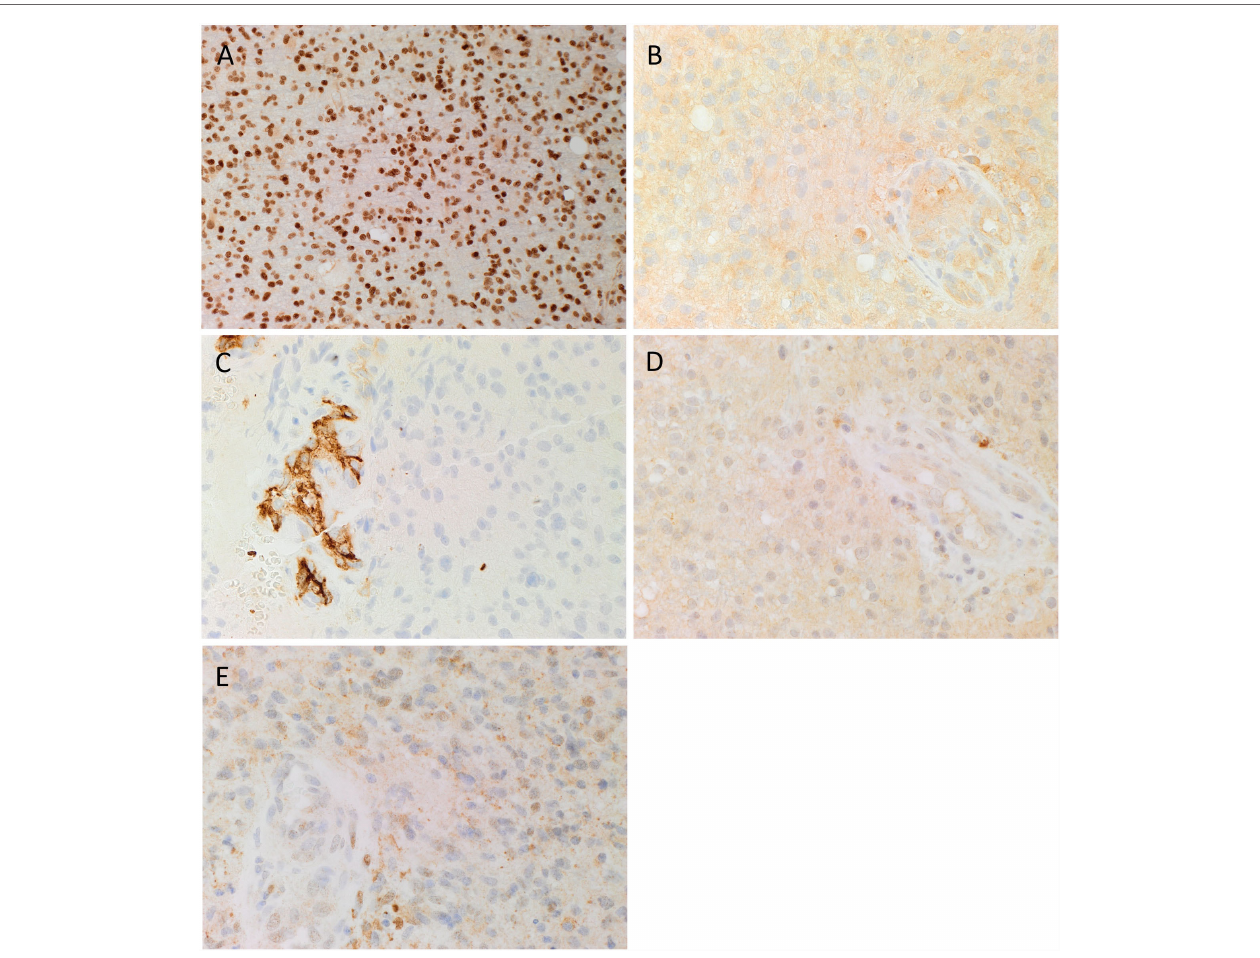
FigUre 1 | representative 3,3-diaminobenzidine immunohistochemical stained images demonstrating cytoplasmic expression of sOX2 [(a), brown], Prr [(B), brown] by cells within gBM, and the endothelium of the microvessels . ACE [ (c) , brown] was present only in the endothelium of the microvessels with no staining of the cells within the tumor. Cytoplasmic and nuclear staining of ATIIR1 [ (D) , brown] and ATIIR2 [ (e) , brown] was observed on the cells within the tumor and the endothelium of the microvessels. Cell nuclei were counterstained with hematoxylin [ (a–e) , blue]. Original magnification: 400 ×